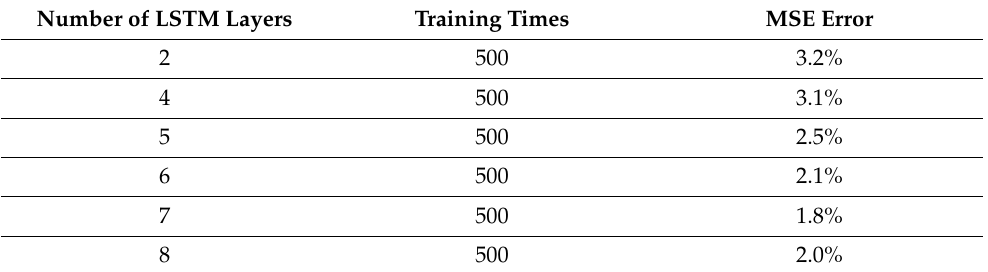
Table 2. Number of layers of LSTM and prediction results.